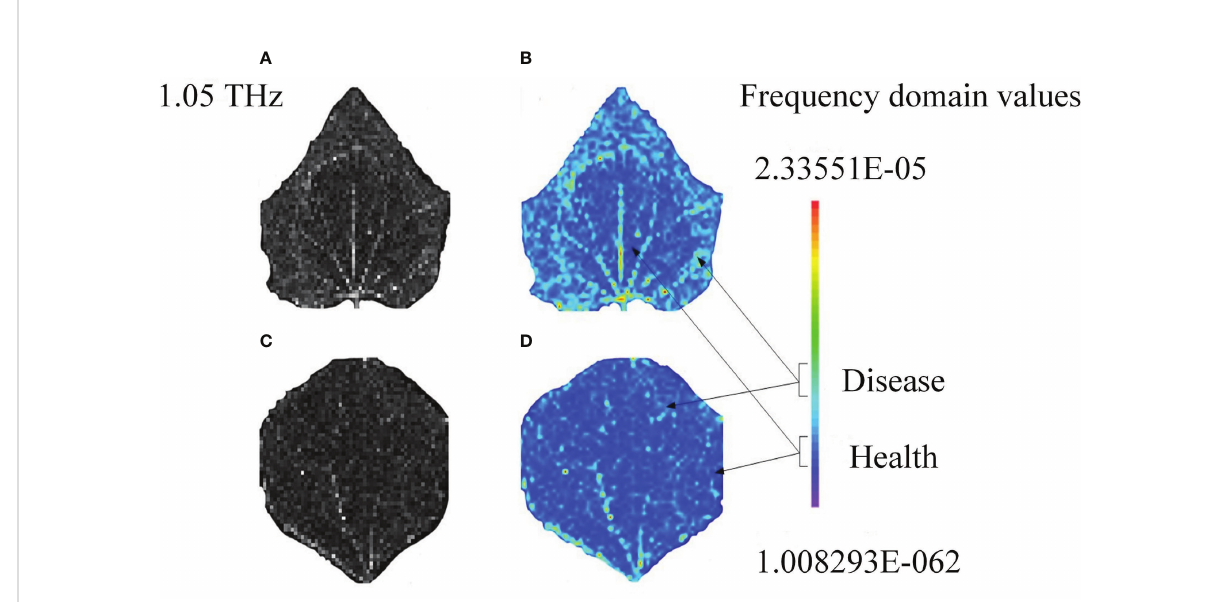
FIGURE 10 Terahertz characteristic images of cucumber powdery mildew: Feature grayscale images of (A) Sample 1 and (C) Sample 2; pseudo-colour rendering of (B) Sample 1 and (D) Sample